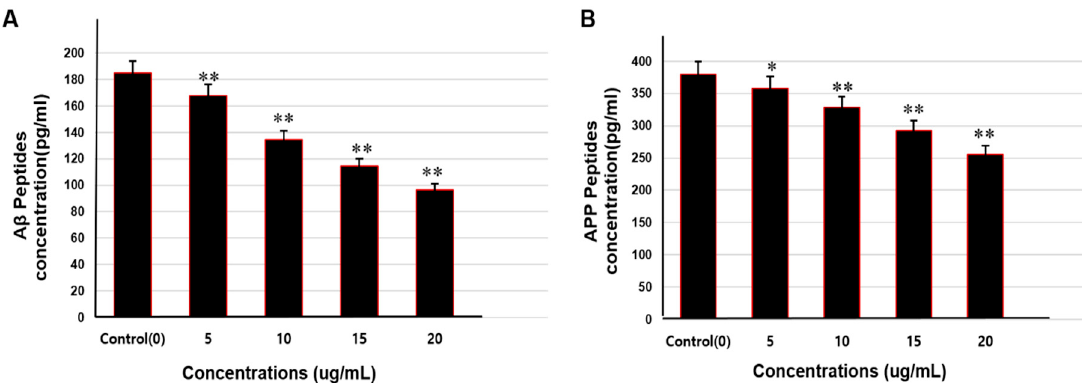
Figure 7. Effect of theasaponin E1 on the level of A β peptides and APP level quantified by ELISA (due to enhancement or reduction in the activities of APP processing and A β amyloid producing or degrading enzymes). ( A ) A β quantification by ELISA after treatment of the cells with various concentrations of E1 theasaponin. ( B ) APP quantification by ELISA after treatment of the cells with various concentration of E1 theasaponin. Data are expressed as mean ± SEM. Data were analysed with one-way ANOVA ( n = 3). Data are statistically significant at p < 0.05. (* p < 0.05; ** p < 0.01 to control